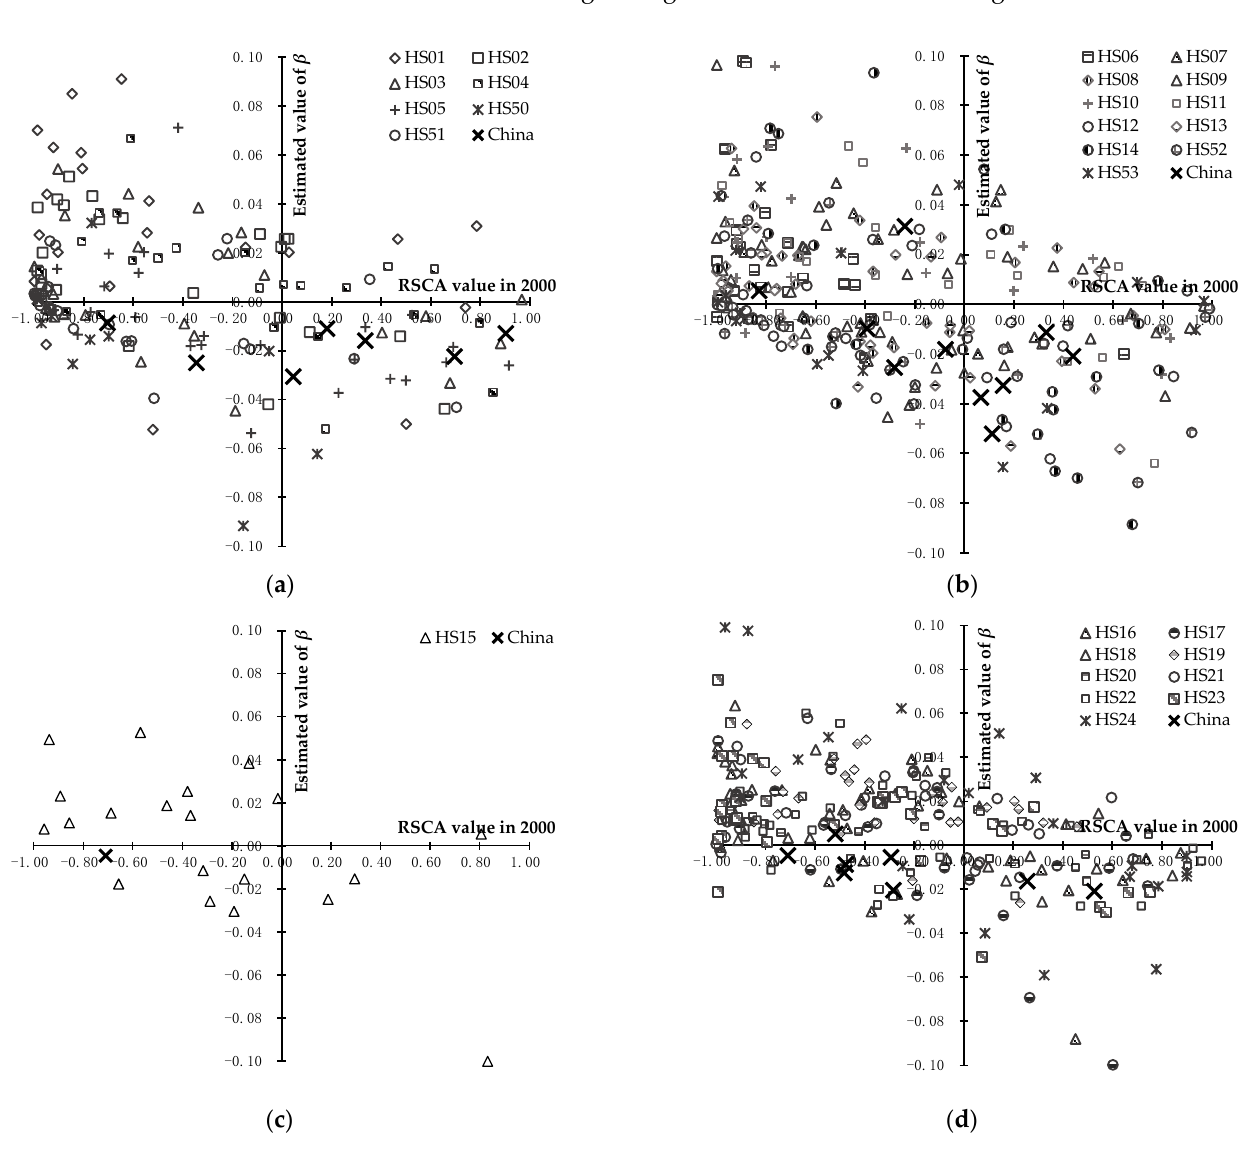
Figure 6. The mean annual change pace of the RSCA values of 4 categories of agricultural products in countries along the B&R and China from 2000 to 2018. ( a ) the first category of agricultural products (live animals and animal products, including HS01–HS05 and HS50–HS51); ( b ) the second category of agricultural products (plant products, including HS06–HS14 and HS52–HS53); ( c ) the third category of agricultural products (animal and vegetable oils and fats, including HS15); ( d ) the fourth category of agricultural products (food, beverages and tobacco, including HS16–HS24). The x -axis represents the RSCA value in 2000; and the y -axis represents the estimated value of β A reveal an increase in comparative advantage from 2000 to 2018, and β A decrease in comparative advantage from 2000 to